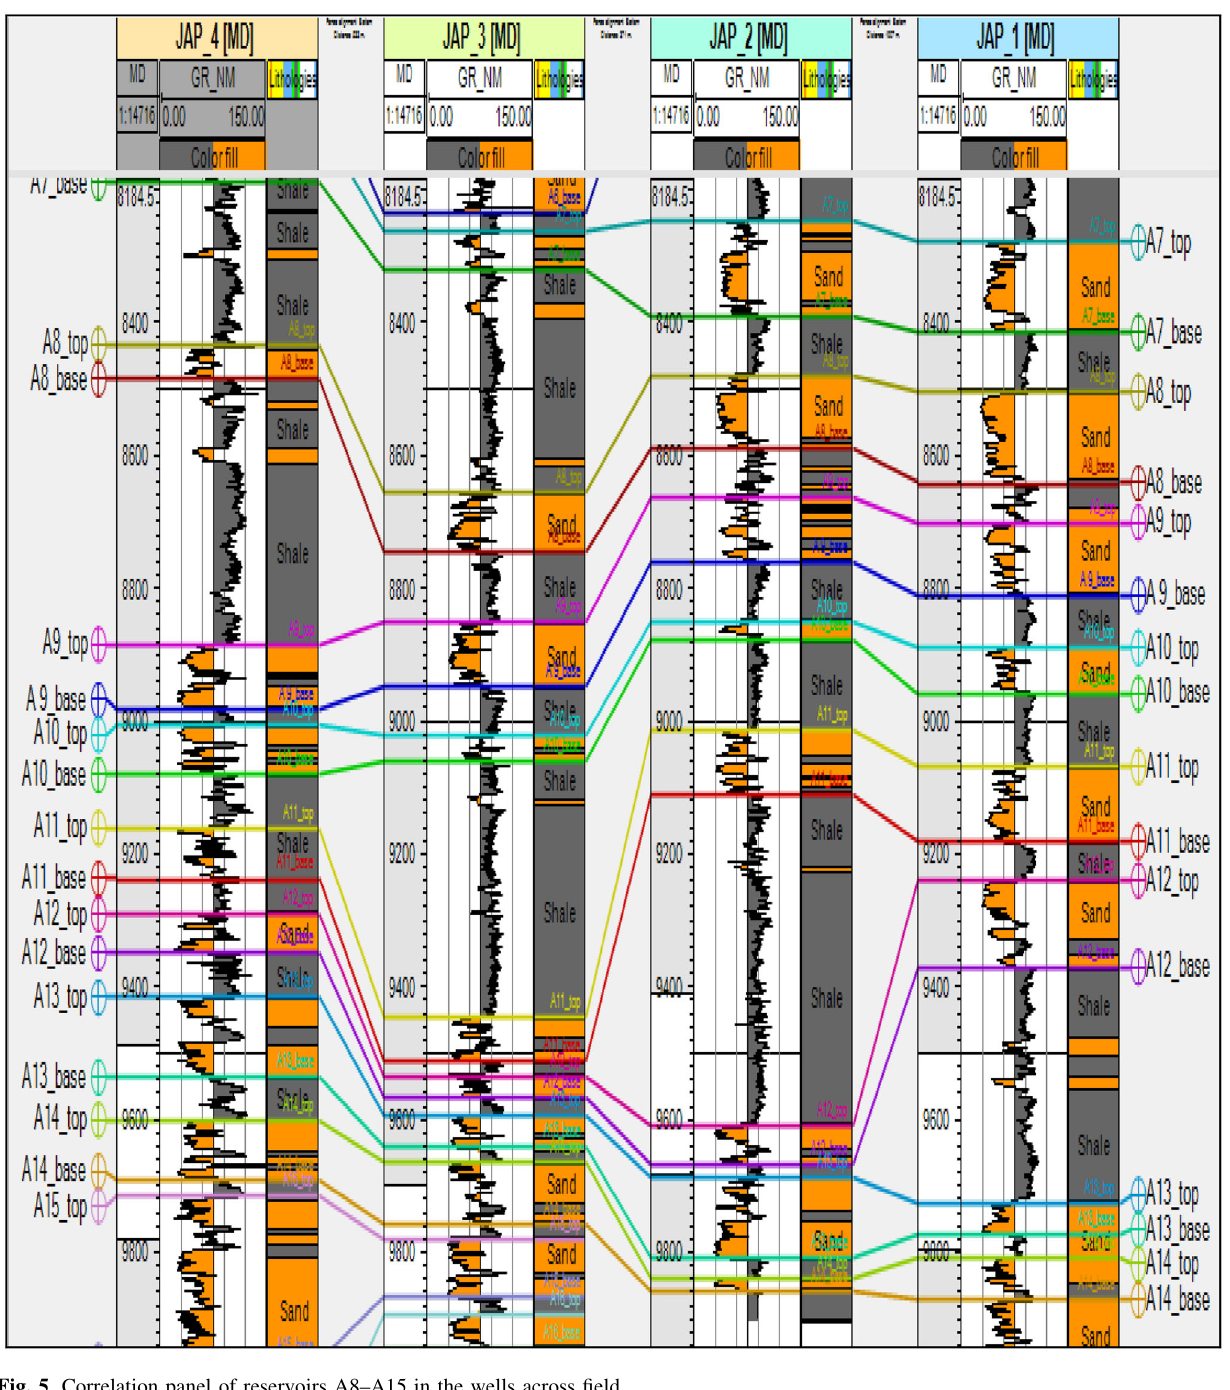
Fig. 5 Correlation panel of reservoirs A8–A15 in the wells across